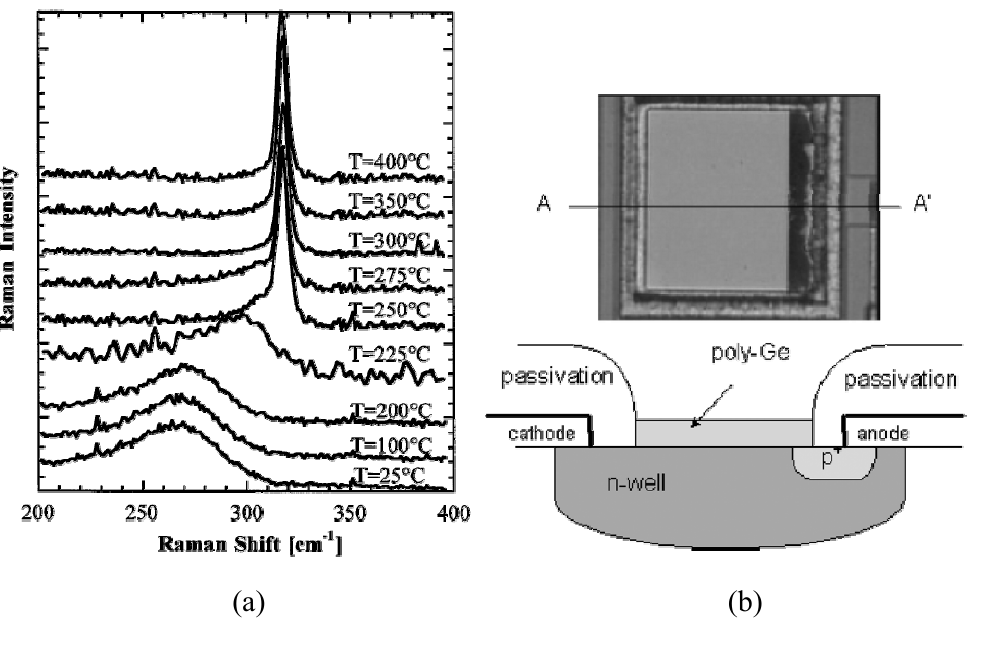
Figure 1. (a) Raman spectra of the Ge on Si samples grown at different temperatures by thermal evaporation method. From [6]. (b) Photograph of one pixel of the digital camera (top) and a sketch of its cross section. From